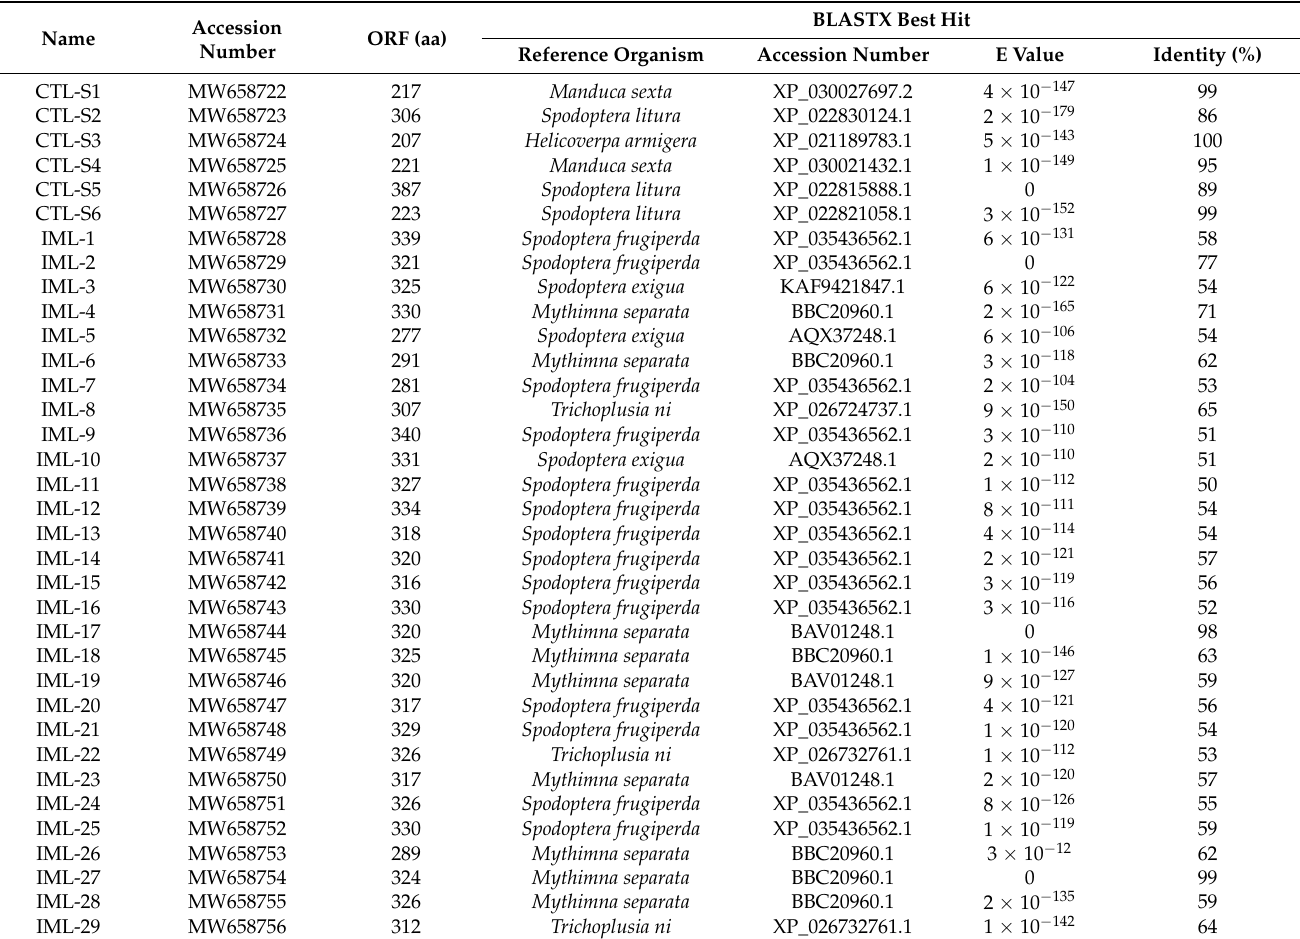
Table 2. M. separata CTL genes identified from